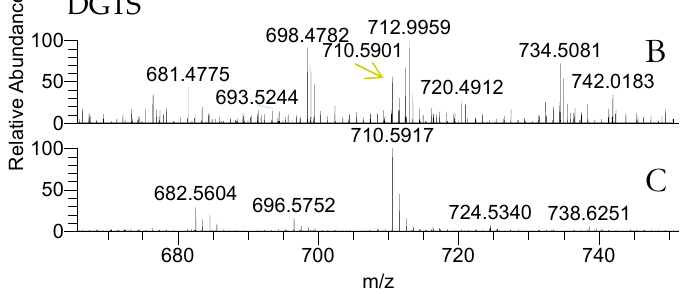
Figure 4. LC–MS of diacyglyceryl- N , N , N -trimethyl homoserine (DGTS) as [M + H] + ions in the LC–MS spectra of blade (B) and conchocelis (C).